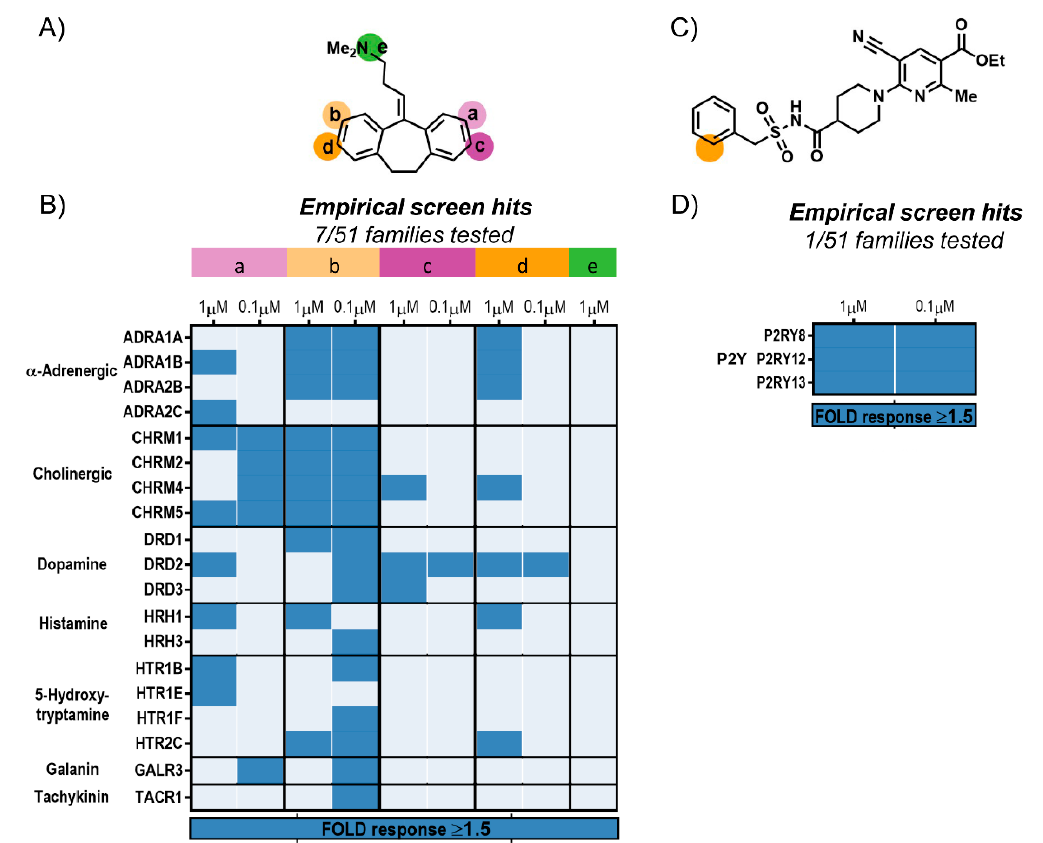
Figure 6. NanoBRET screen of Amitriptyline and AZD1283 tracer candidates. ( A ) Structure of Amitriptyline with modifiable positions marked. ( B ) NanoBRET screen across 184 HiBiT-GPCRs from 51 families revealed specific interactions ( ≥ 1.5-fold response) with GPCRs from seven families. Amitriptyline-b-2-NB590 had a substantially broader binding profile exhibiting specific interactions with 17 GPCRs. ( C ) Structure of AZD1283 with modifiable position marked. ( D ) NanoBRET screen revealed specific interactions ( ≥ 1.5-fold response) with 3 Purinergic GPCRs.